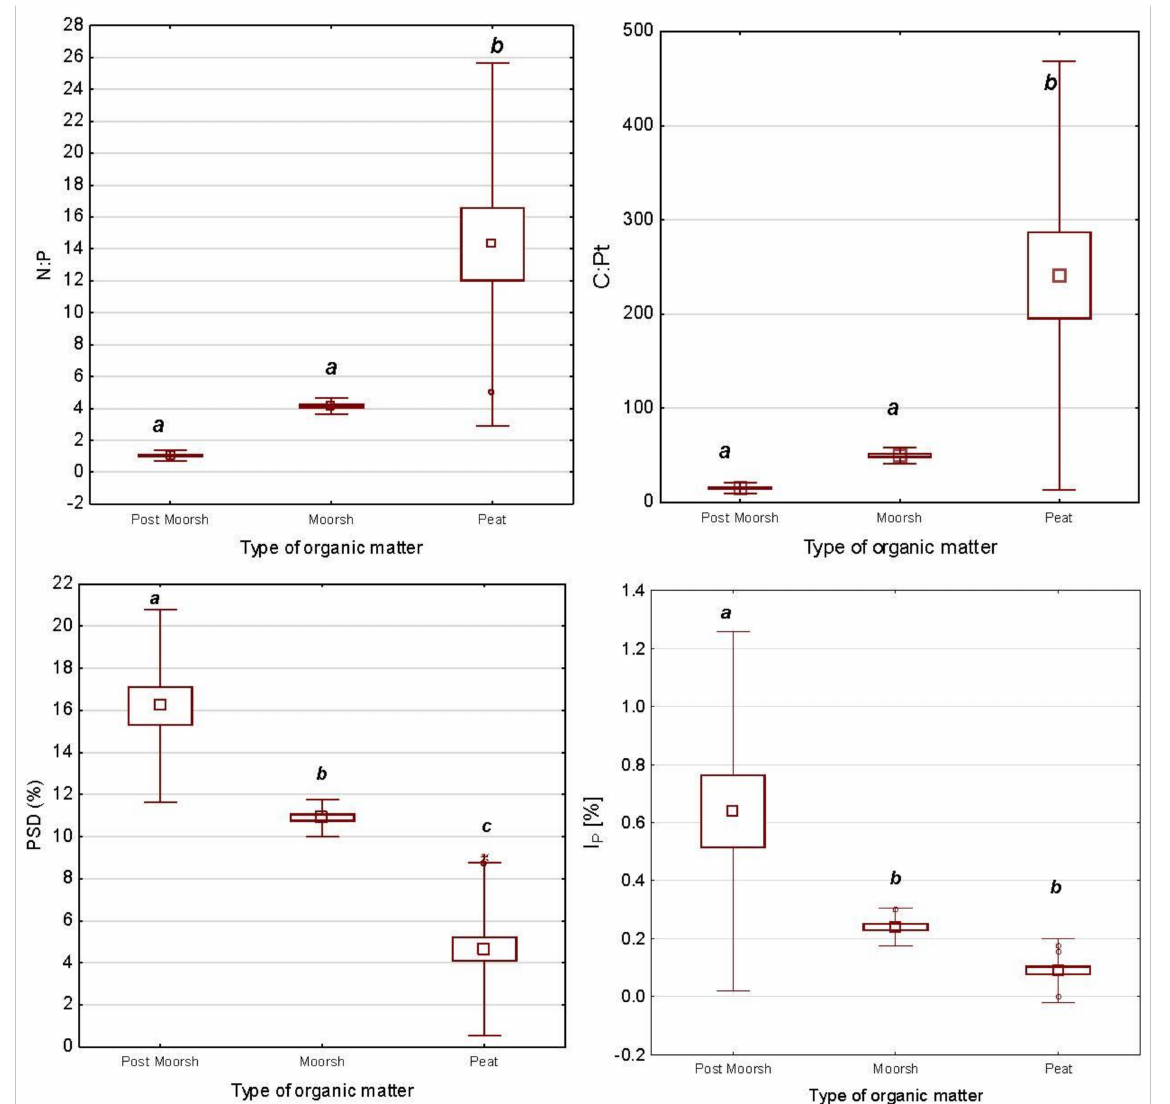
Figure 6. Variability range of calculated parameters (PSD, C:P, N:P, Ip) 1 in soil organic horizons categorised by type of organic matter for: Post Moorsh (A horizons of P1), Moorsh (M horizons of P2), Peat (O horizons of P2 and P3). Explanation: central squares—mean values; boxes—mean values ± standard errors; whiskers—mean values ± 2*standard deviations; circle—outliers; asterisk—extreme; letters a, b, c—significance of differences (homogeneous groups of means) by RIR Tukey test (at p < 0.05). 1 Pt—total P; PSD—P saturation degree; Ip—P solubility